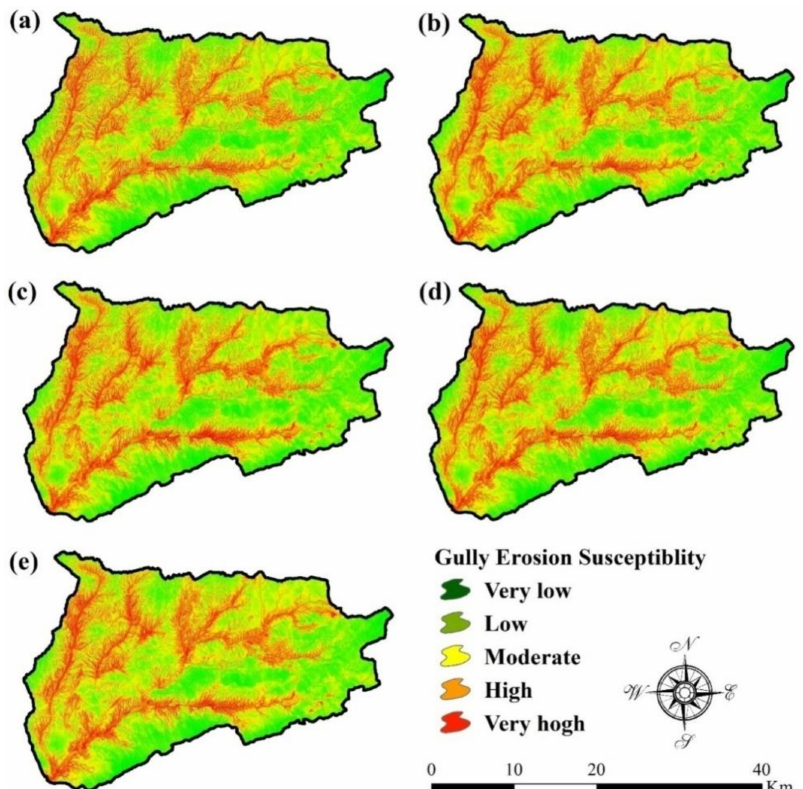
Figure 6. Gully erosion susceptibility mapping using the GLM model: ( a ) 50 / 50, ( b ) 60 / 40, ( c ) 70 / 30, ( d ) 80 / 20, ( e ) 90 /